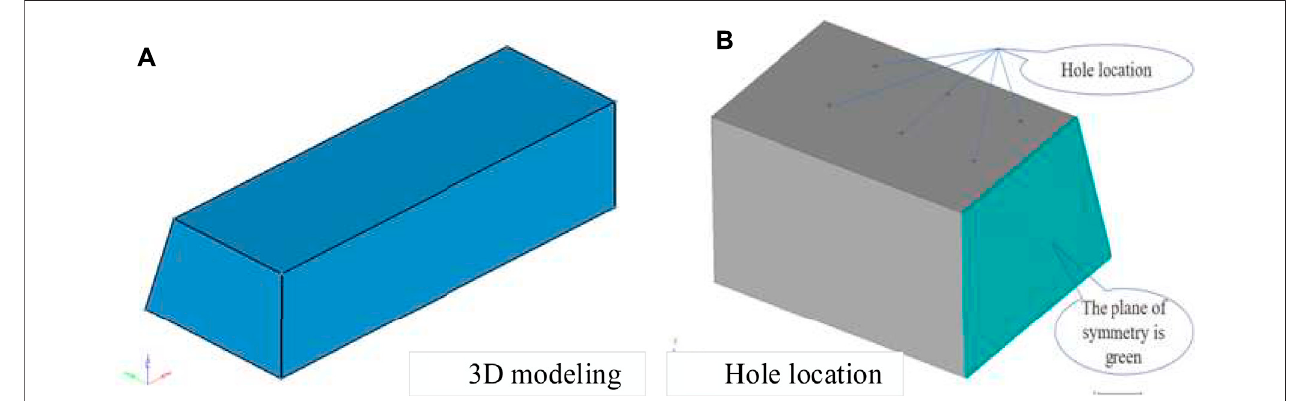
FIGURE 3 | Model design. (A) 3D modeling. (B) Hole